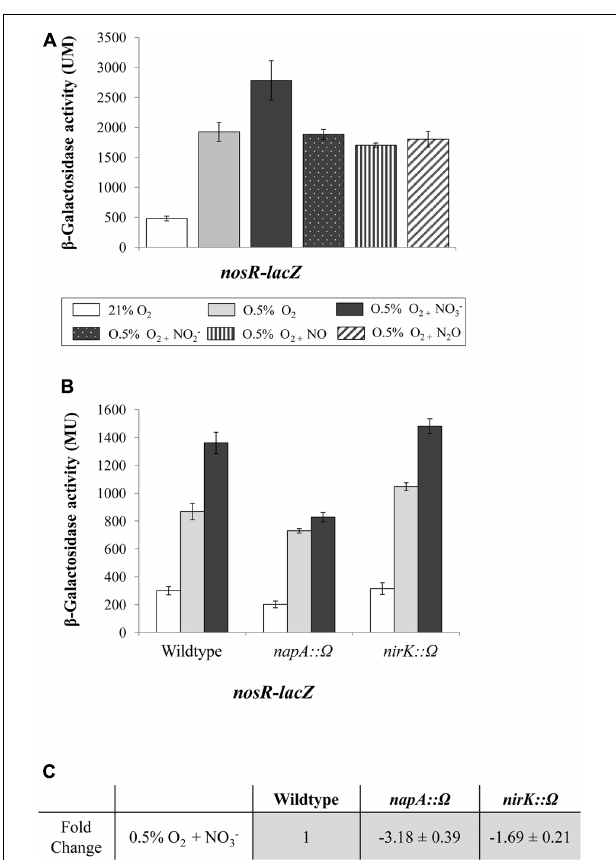
FIGURE 3 | Low-oxygen is the main inducer of nosRZDFYLX expression. (A) β -Galactosidase activity derived from a nosR-lacZ fusion in B. diazoefficiens cells grown oxically or under 0.5% O 2 for 24 h. Then, cells were incubated for another 5 h with or without 10 mM KNO 3 , 500 µ M NaNO 2 , 50 µ M NO, and 30 mM N 2 O. (B) β -Galactosidase activity from the nosR - lacZ fusion in the B. diazoefficiens WT, and mutant strains napA and nirK . Cells were grown oxically (white bars) or under 0.5% O 2 in the absence (gray bars) or in the presence of 10 mM KNO 3 (black bars) during 24 h. (C) Expression of nosR measured by qRT-PCR. After RNA isolation from cells grown under 0.5% O 2 in the presence of 10 mM KNO 3 , qRT-PCR reactions were performed with cDNA synthesized from three independent RNA samples assayed in three parallel reactions. Fold-change values refer to differences of expression in the napA and nirK mutants relative to the WT. In (A,B) data expressed as Miller units (MU) are means with standard error bars from at least two independent cultures, assayed in